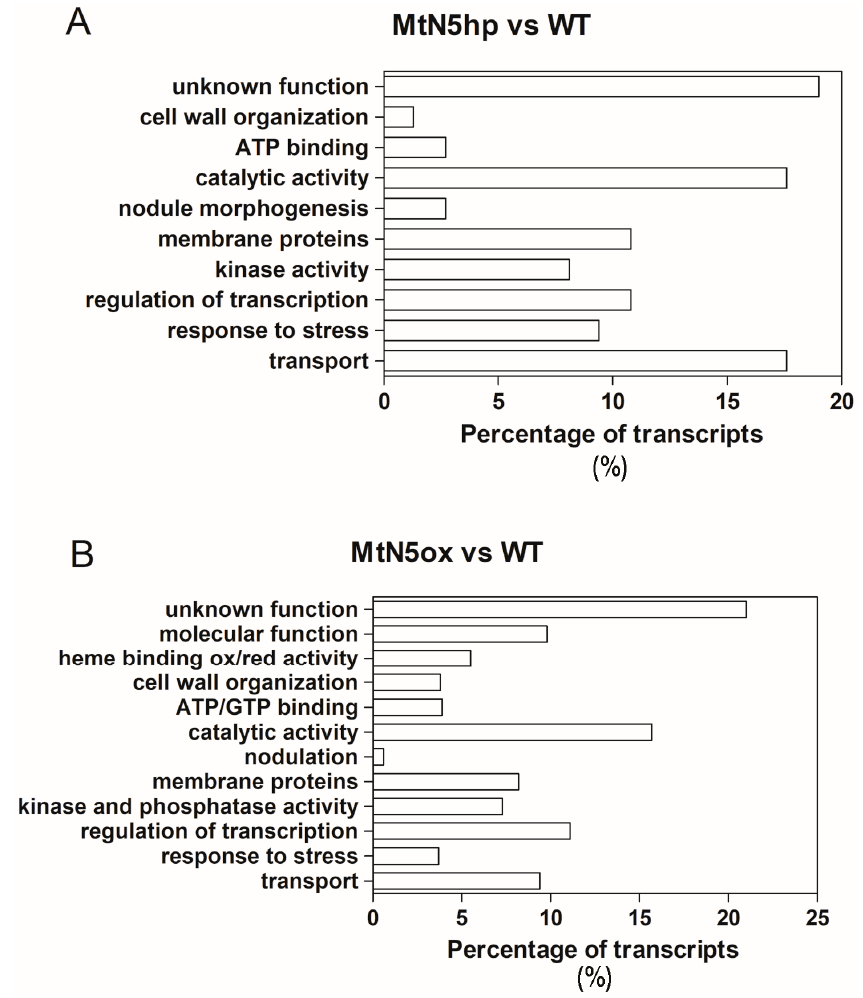
Figure 3. Main functional categories of differentially expressed genes (DEGs). Differentially regulated transcripts in the comparison MtN5hp vs. WT ( A ) and MtN5ox vs. WT ( B ) were grouped into main functional categories. Transcripts without any annotation information were collected into ‘unknown function’ category.